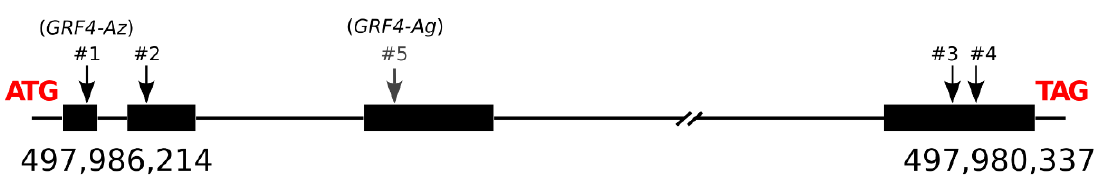
Figure 3. Schematic representation of the Zavitan GRF4-A gene ( GRF4-Az ). The black arrows indicate single nucleotide polymorphisms (SNPs) between Zavitan and Svevo while the gray arrow marks the unique SNP of WEW accession G18-16 ( GRF4-Ag ).